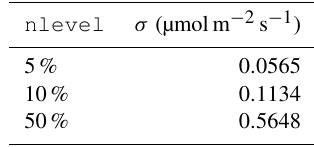
Table 1. Noise level and corresponding noise standard deviation σ used in the 6-week case study